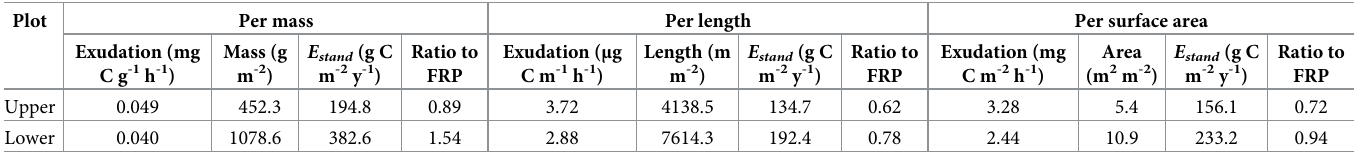
exudation based on relatively thin roots. On the other hand, exudation determined based on